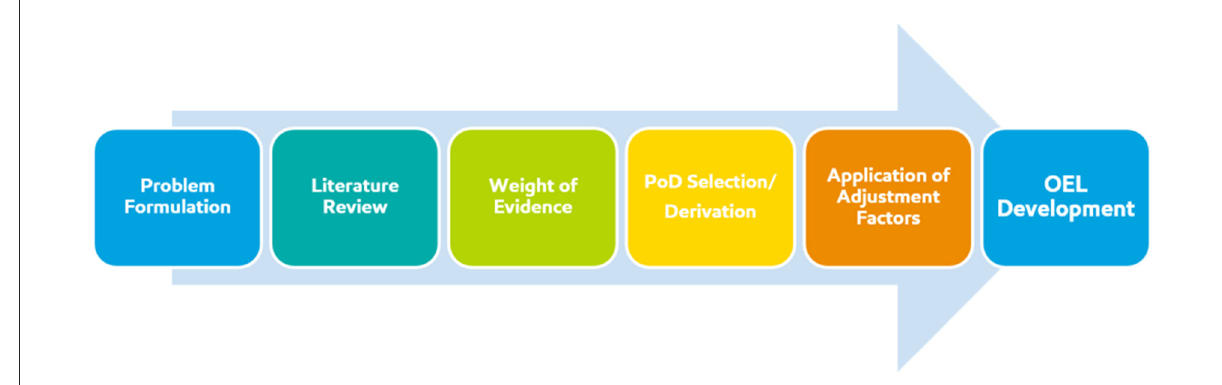
FIGURE1 Overview of basic risk assessment steps involved in OEL derivation.